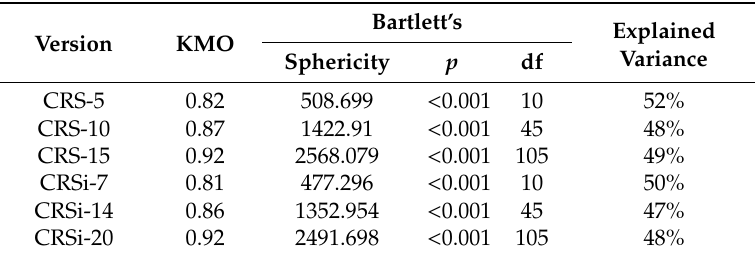
Table 2. Results of the exploratory factor analysis of the CRS scales. Bartlett’s